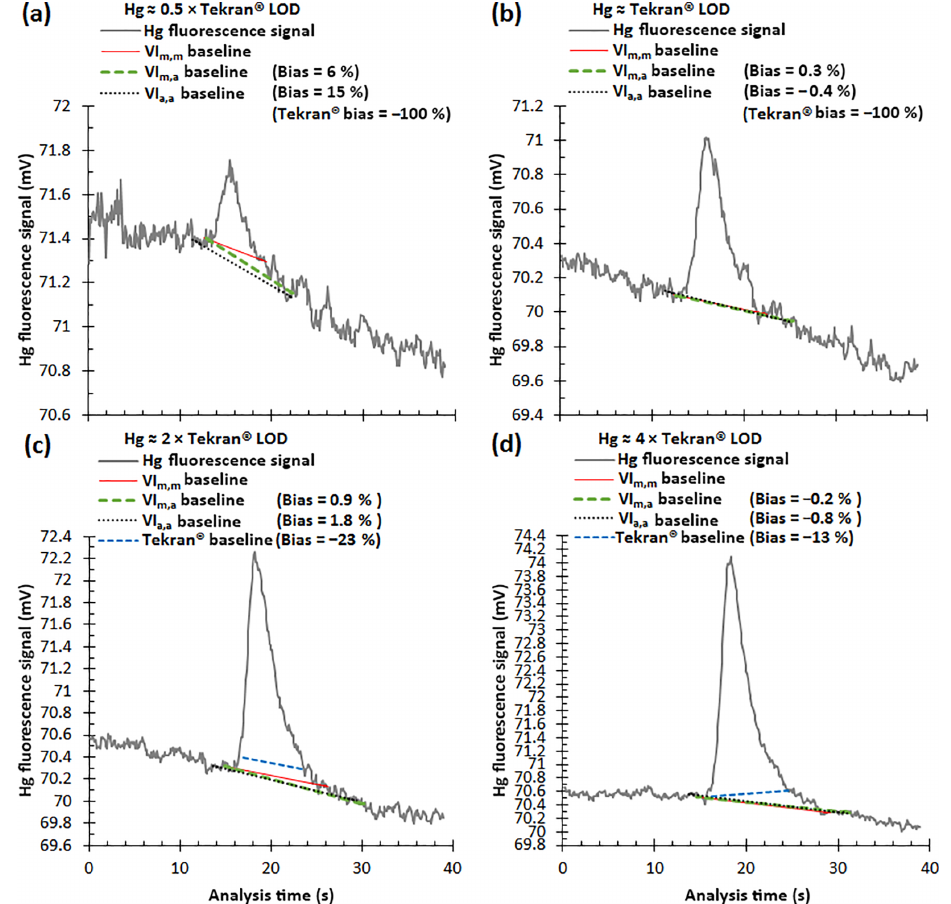
Figure 4. Comparison of Hg fluorescence baselines calculated by applying manual (VI m,m method), automated (Tekran ® and VI a,a methods), and semiautomated (VI m,a method) Hg thermal desorption peak definition methods to samples with Hg loadings of approximately (a) 0.5, (b) 1, (c) 2, and (d) 4 times the limit of detection of the Tekran ® method ( ∼ 0.8pg). Measurements were made with a 2537A instrument. Biases in the Hg loadings derived from the Tekran ® method and the VI-based methods are indicated. Biases are expressed relative to the loadings derived from the VI m,m method and are negative when the VI m,m -based loadings are higher. The Tekran ® baselines are missing from panels (a) and (b) because the peaks are not detected by the Tekran ®